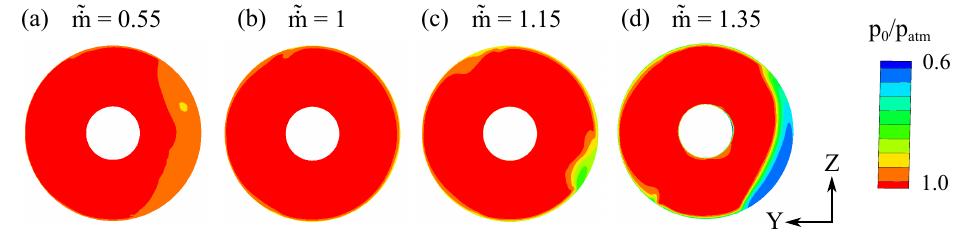
Figure 4. P 0 contours at fan-face: ( a ) low-speed separation; ( b ) attached flow; ( c , d ) high speed